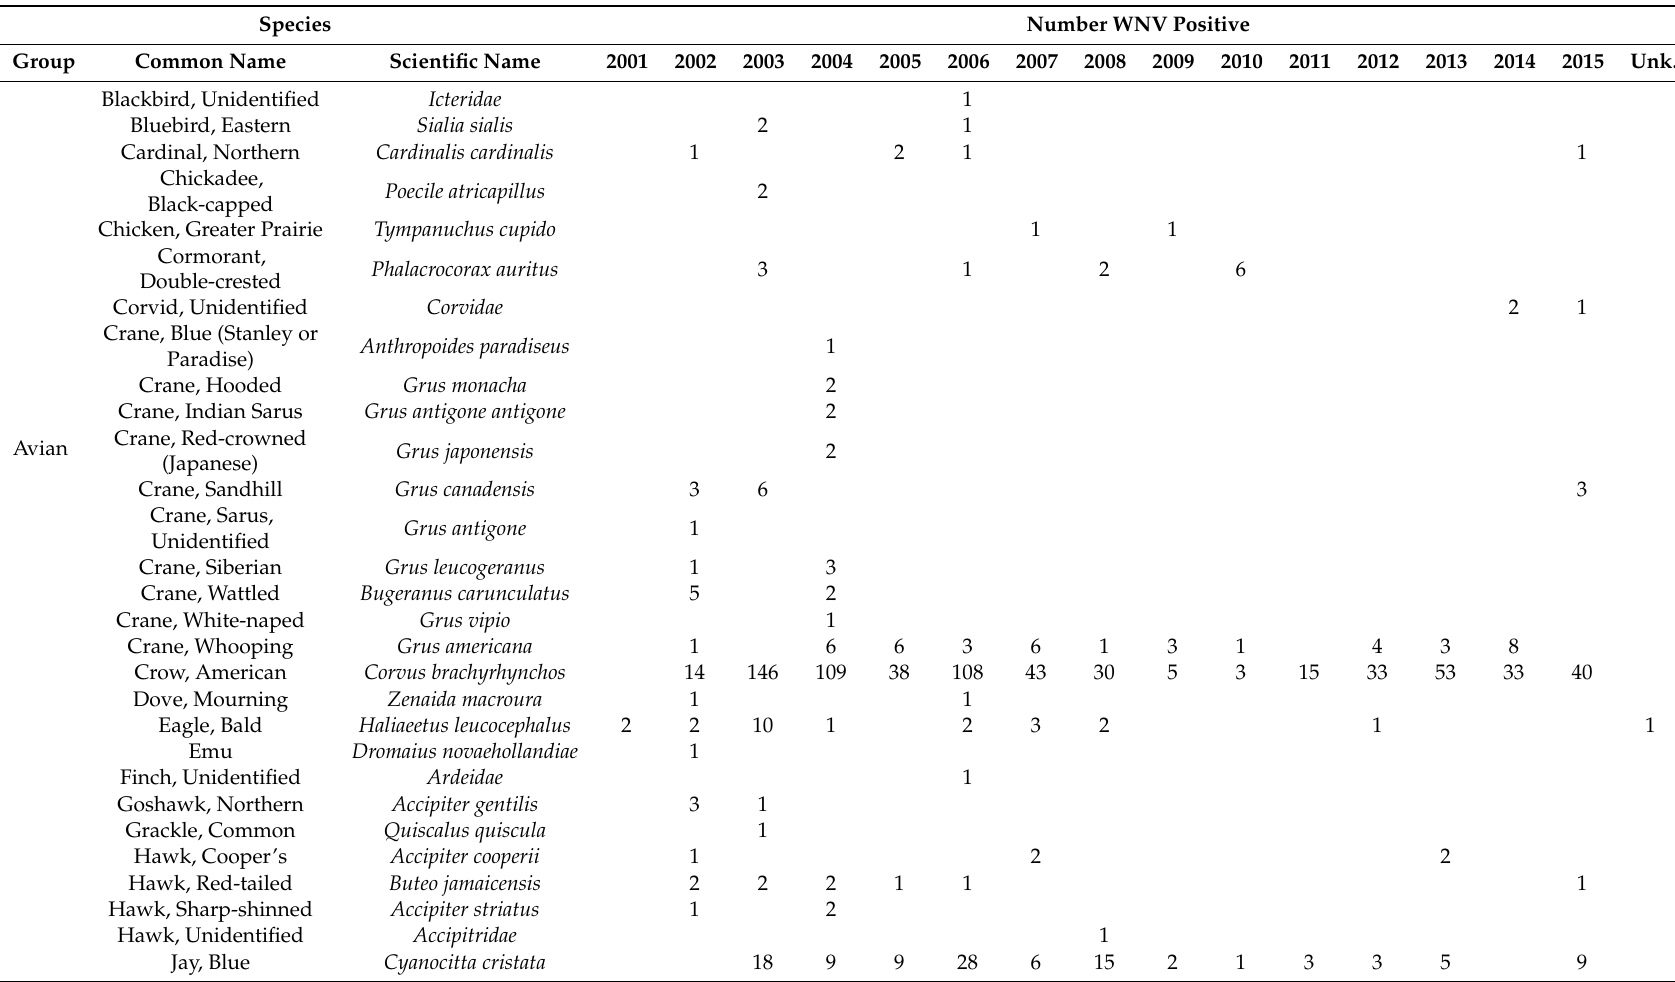
Table 2. In total, 1636 submissions tested positive for WNV in Wisconsin from 2001 to 2016, comprising 50 di ff erent species (avian: 20 families, 42 species; mammalian: 6 families, 8